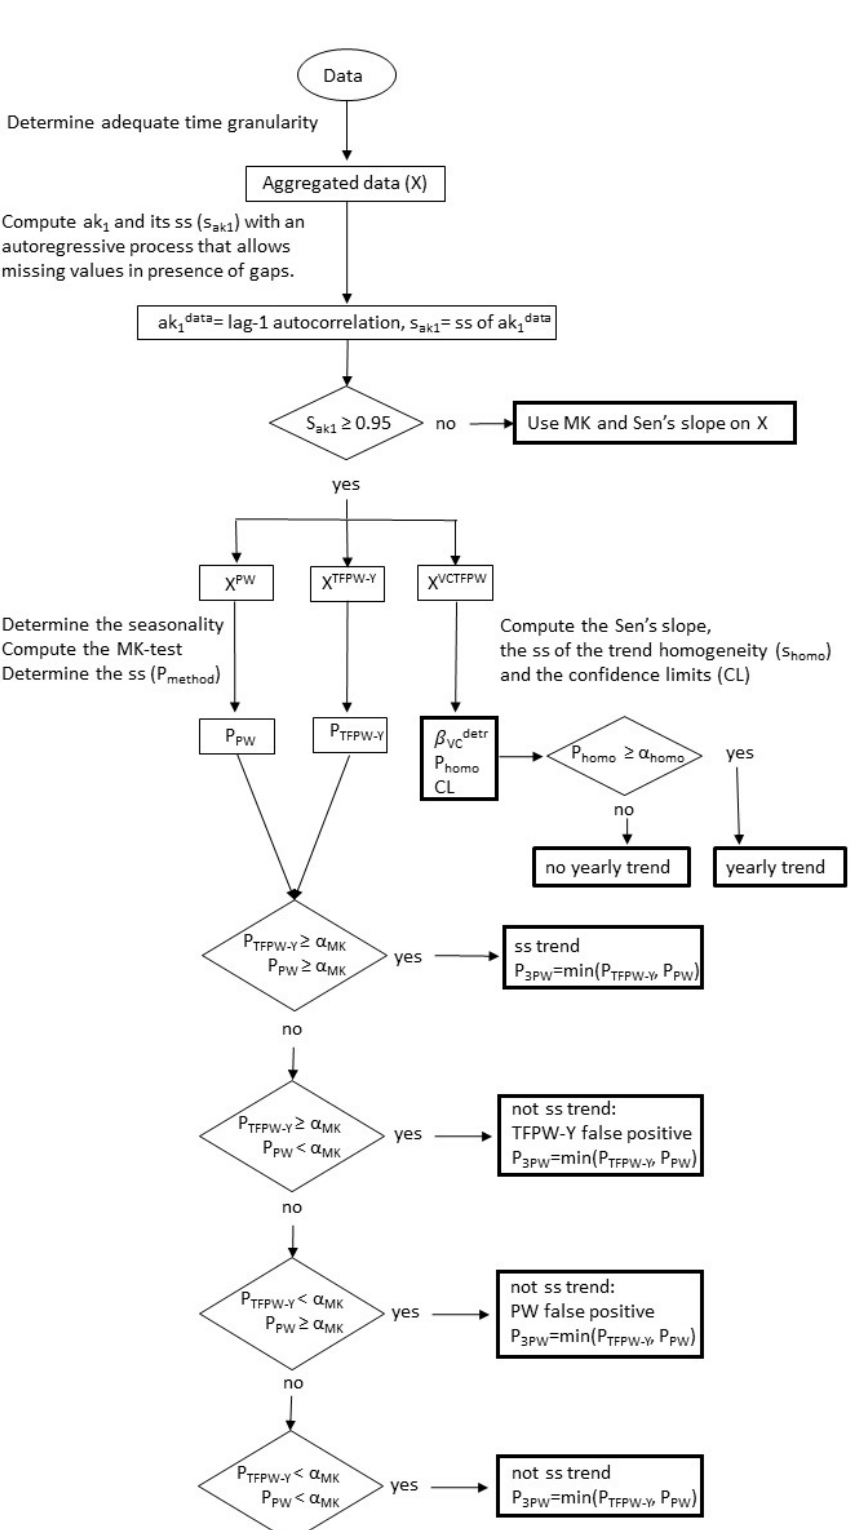
Figure 1. Scheme of the new 3PW algorithm. α MK is the desired confidence limit for the MK test and α homo the desired confidence limit for the homogeneity test between temporal segments. The values applied for this study are α MK = 0 . 95 and α homo = 0 .